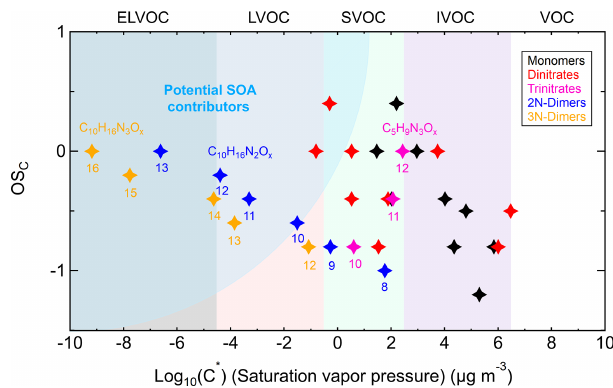
Figure 8. Volatility distribution of different organonitrates formed from NO 3 -initiated isoprene oxidation. The volatility classes are in- dicated along the top with corresponding colors in the plot. The position of potential SOA contributors is determined depending on the exact functionalities of molecules adapted from Bianchi et al.